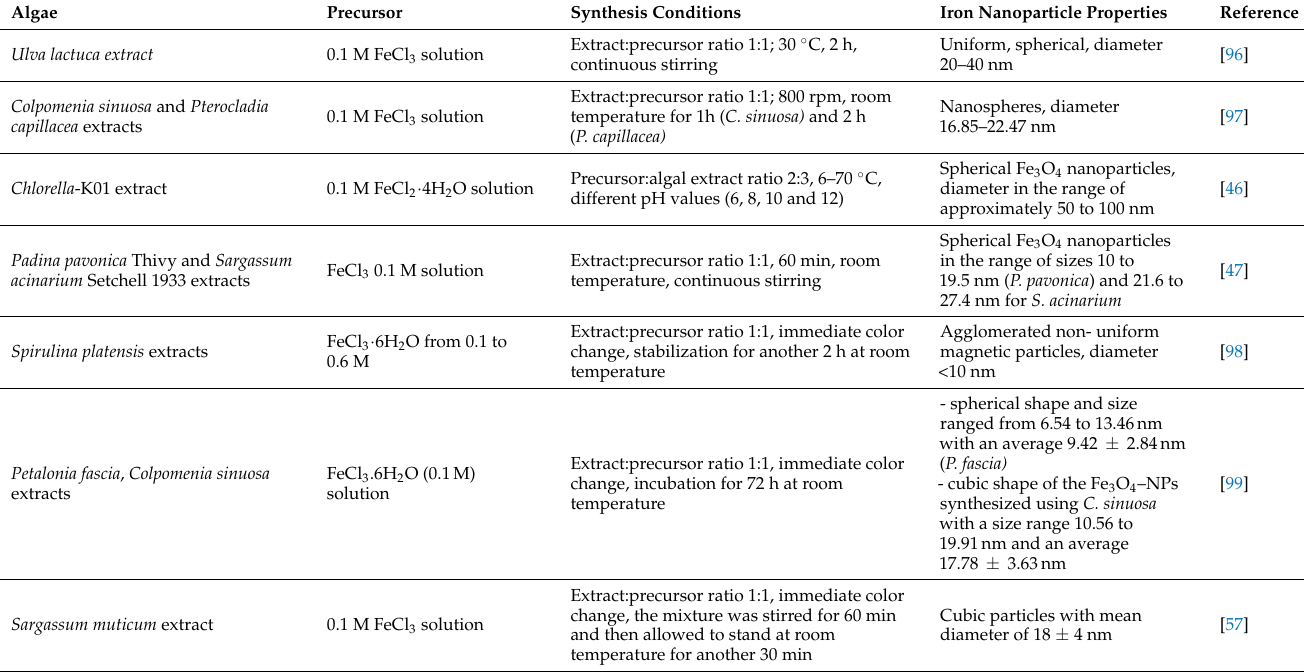
Table 2. Some examples of use of algae for synthesis of iron